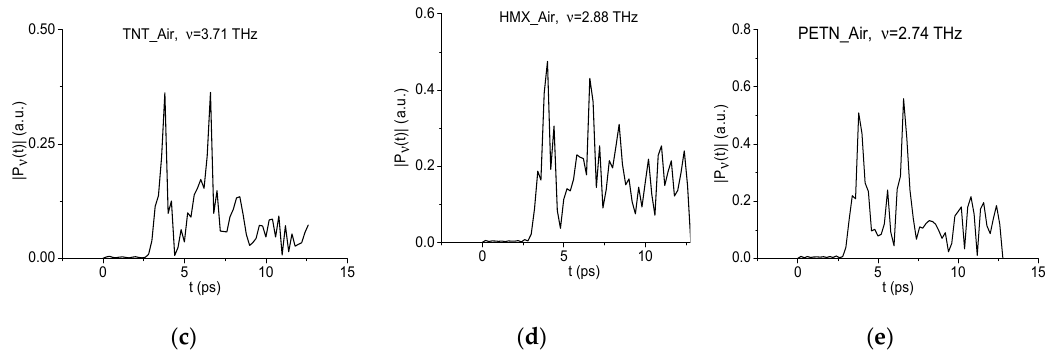
Figure 9. Spectra of the standard signals HMX_Air, PETN_Air and TNT_Air depicted in the frequency ranges ν = [0.6, 2.6] THz ( a ) and [2.6, 4.0] THz ( b ). Spectral line dynamics at the frequencies ν = 3.71 THz (TNT_Air) ( c ), 2.88 THz (HMX_Air) (d), and 2.74 THz (PETN_Air) ( e ).